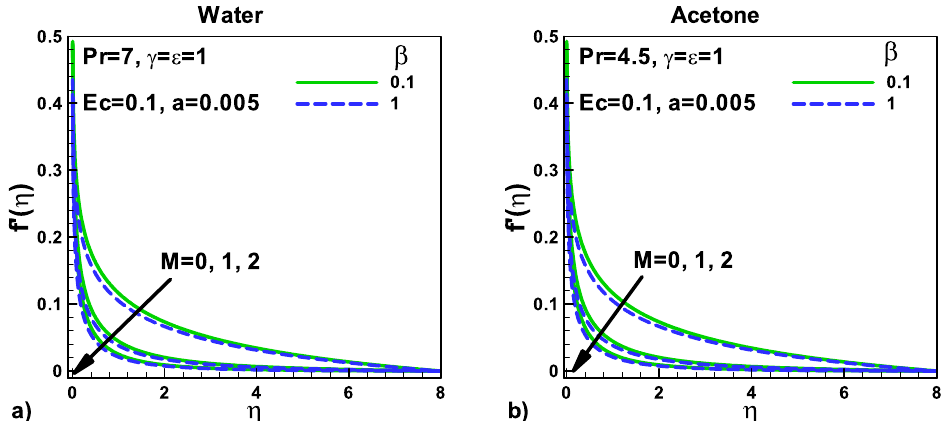
Figure 3. Effects of velocity slip and magnetic parameters on dimensionless velocity for ( a ) water ( b ) Acetone.